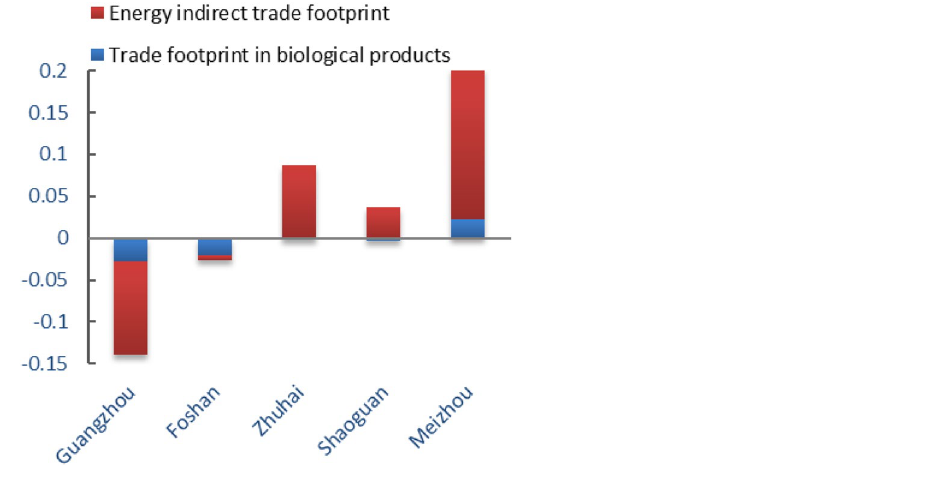
Figure 11. The per capita trade footprint of 5 prefecture-level cities in Guangdong in